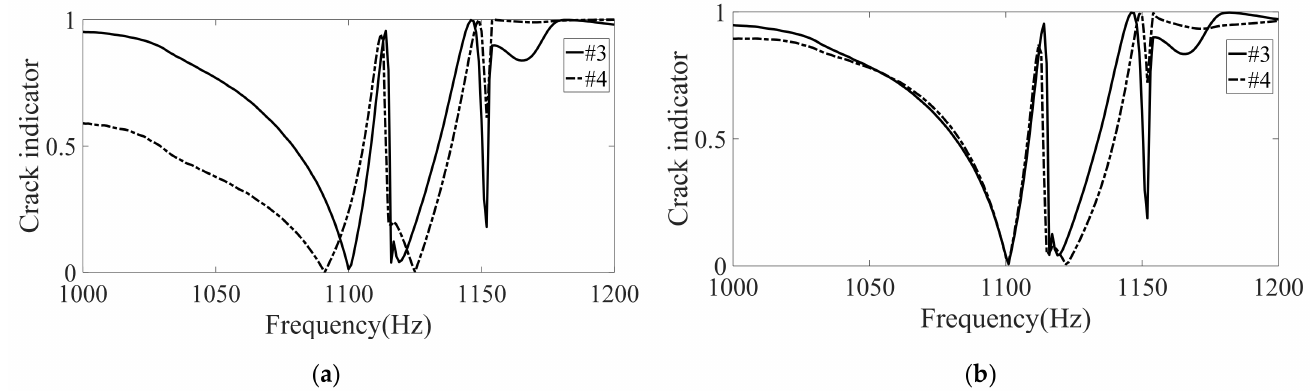
Figure 10. Crack indicator in X-Y plane (rear): ( a ) frequency response function and ( b ) acceleration only.